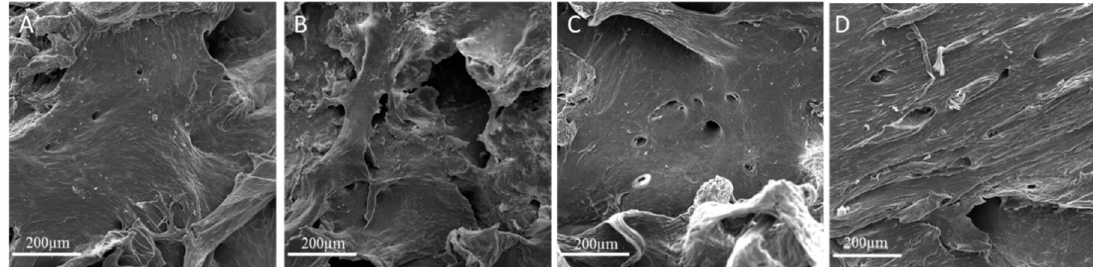
Figure 4. Scansion electron microscopy (SEM) images of ( A ) bare Lamina, ( B ) APTES-treated Lamina, ( C ) 5 µg/mL GO-coated Lamina and ( D ) 10 µg/mL GO-coated Lamina. Magnification 3000×. Scale bar: 200 µm.